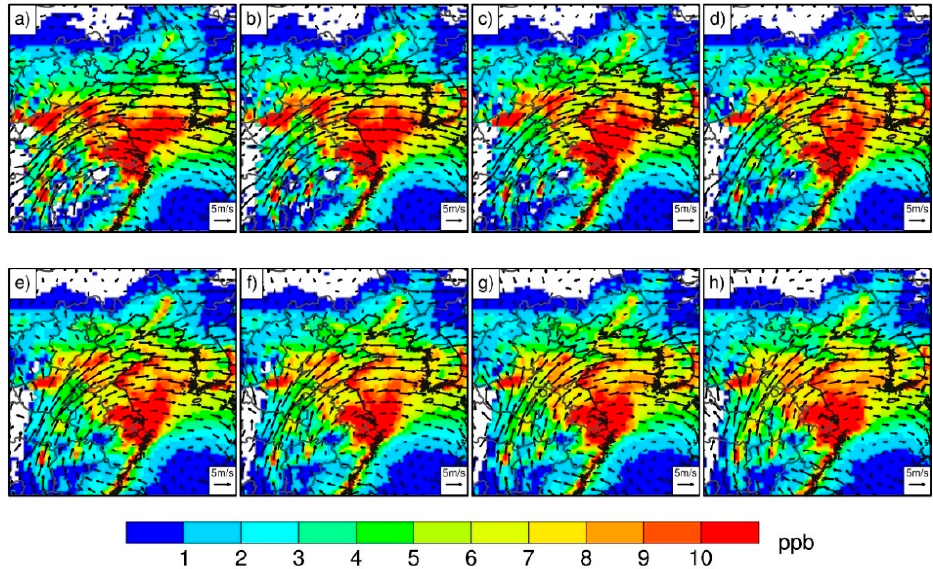
Figure 9. Composite hourly ozone concentrations (shading, units: ppb) from isoprene emissions outside Shandong Province and 850 hPa wind vectors (units: m/s) at ( a – h ) 09:00 to 16:00 local time from 18 July to 28 July 2017.